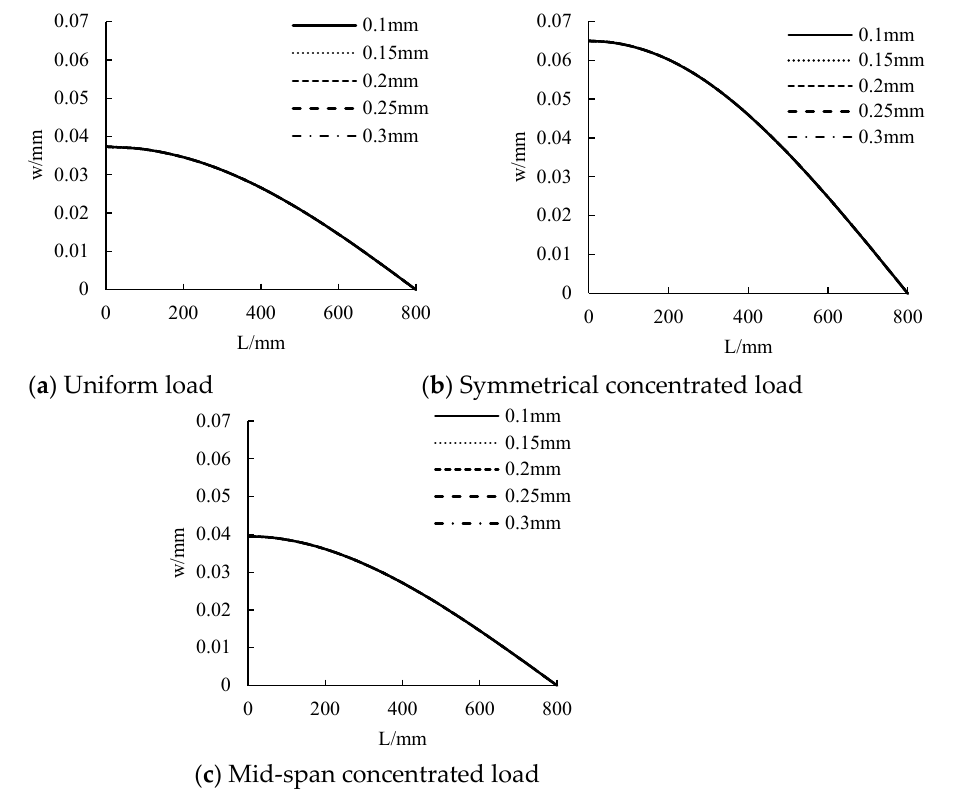
Figure 15. The influence of CFRP sheet’s thickness on displacement.